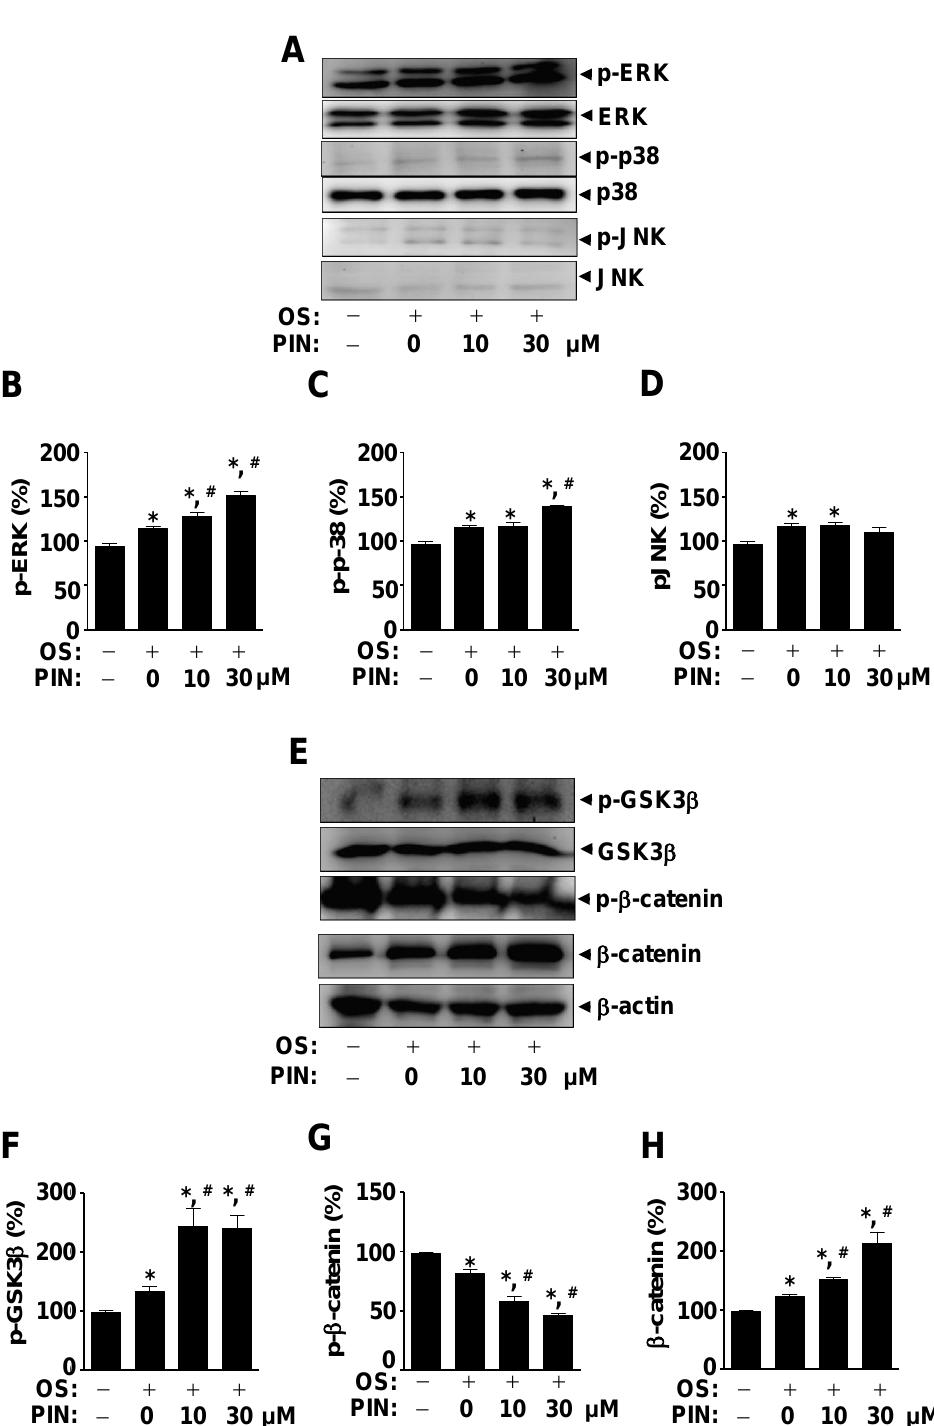
Figure 6. E ff ect of PIN on ERK, JNK, p38, and β -catenin signals during osteoblast di ff erentiation. ( A – G ) After pre-osteoblasts were di ff erentiated with 0 and 30 µ M PIN for 24 h, Phospho (p)-ERK, ERK2, p-p38, p38, p-JNK, and JNK ( A ), and p-GSK3 β , GSK3 β , p- β -catenin, β -catenin, and β -actin (E) were analyzed using western blot analysis. The levels of p-ERK ( B ), p-p38 ( C ), p-JNK ( D ), p-GSK3 β ( F ), p- β -catenin ( G ), and β -catenin ( H ) were represented as relative percentages of the control and are exhibited as a bar graph. Data represent the mean ± S.E.M. of experiments. *, p < 0.05 indicates statistically significant di ff erence, compared with the control. #, p < 0.05 indicates statistically significant di ff erence when compared with